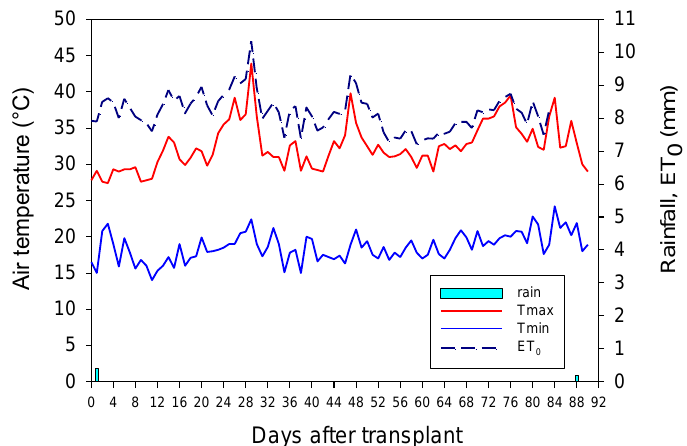
Figure 1. Meteorological course (maximum and minimum air temperatures, rainfall, and reference evapotranspiration (ET 0 )) recorded during the field experiment.